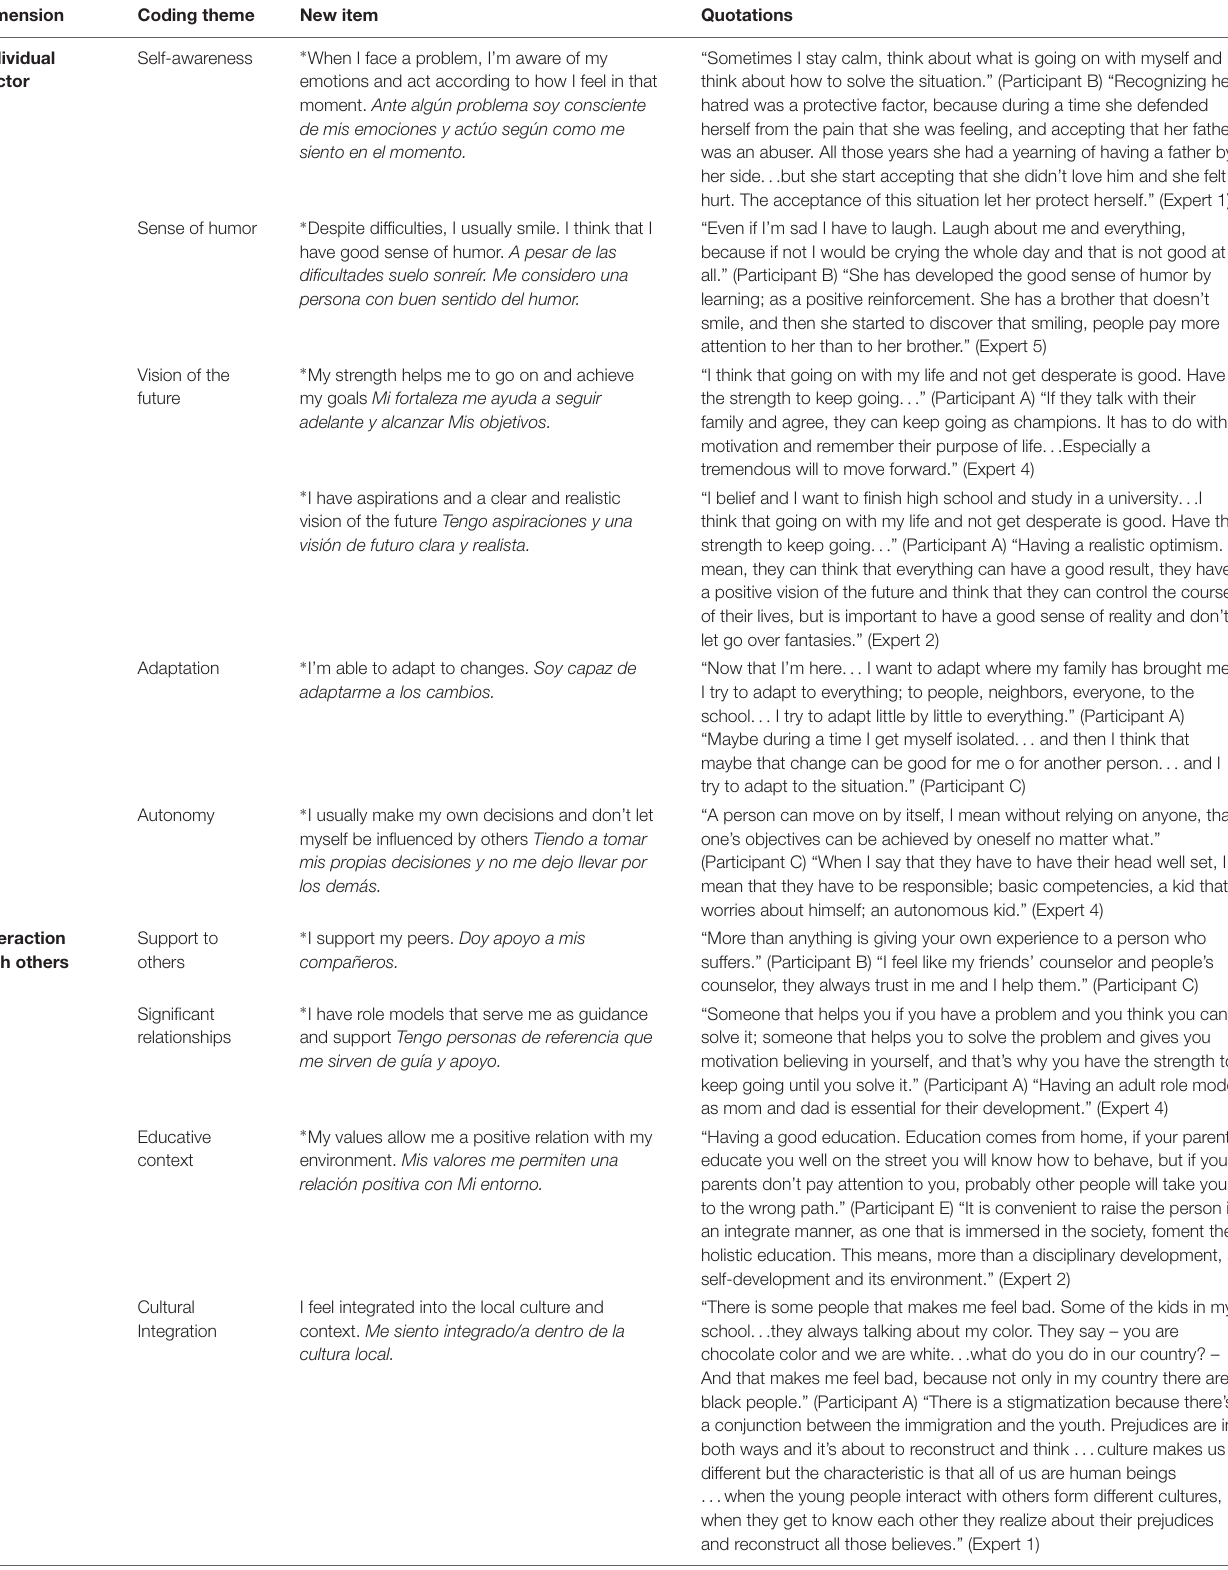
TABLE 2 | Generation of new items. Dimension Coding theme